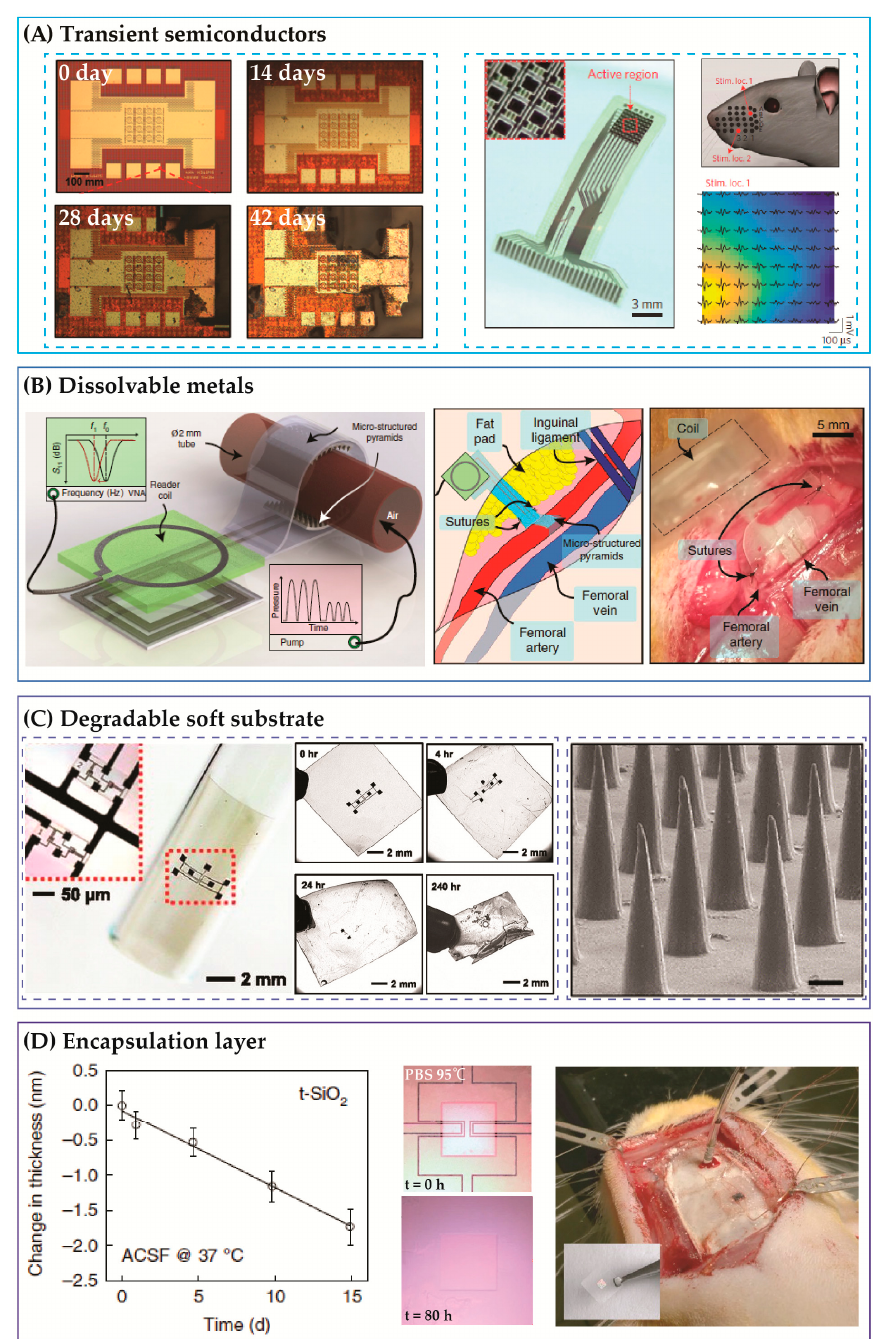
Figure 1. Material systems for biodegradable electronics require all components of encapsulations, metals, semiconductors, and substrates exhibiting the dissolvable property. ( A ) Silicon nanomem- brane as functional semiconducting element. Left: Transient Si based complementary metal-oxide semiconductor (CMOS) devices [9]. Right: An array of Si thin film transistor (TFT) for neuron recording [12]. ( B ) Example of dissolvable metals, where Mg was utilized to form antenna for wireless stimulator and sensors [15]. ( C ) Poly(lactic-co-glycolic acid) (PLGA) as a biodegradable substrate. Left: Transient electronics on a PLGA substrate [16]. Right: Examples of PLGA films used for drug delivery [17]. ( D ) Temporary encapsulation layer capable of dissolving in biofluids. Left: Hydrolysis rate of silicon oxide. Right: An intracranial pressure sensor encapsulated with silicon oxide (SiOx)